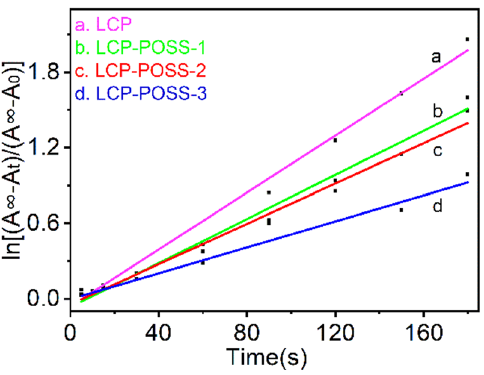
Figure 7: First - order kinetics curves of cis – trans